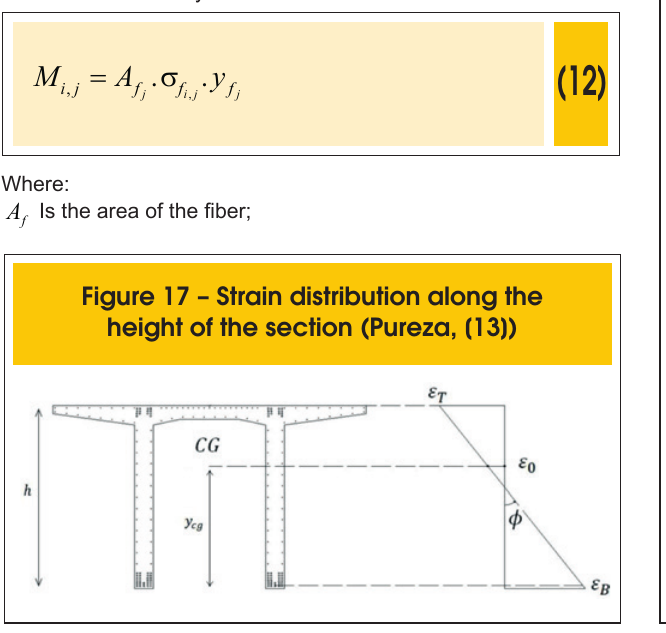
Figure 18 – Cross-section in fibers and